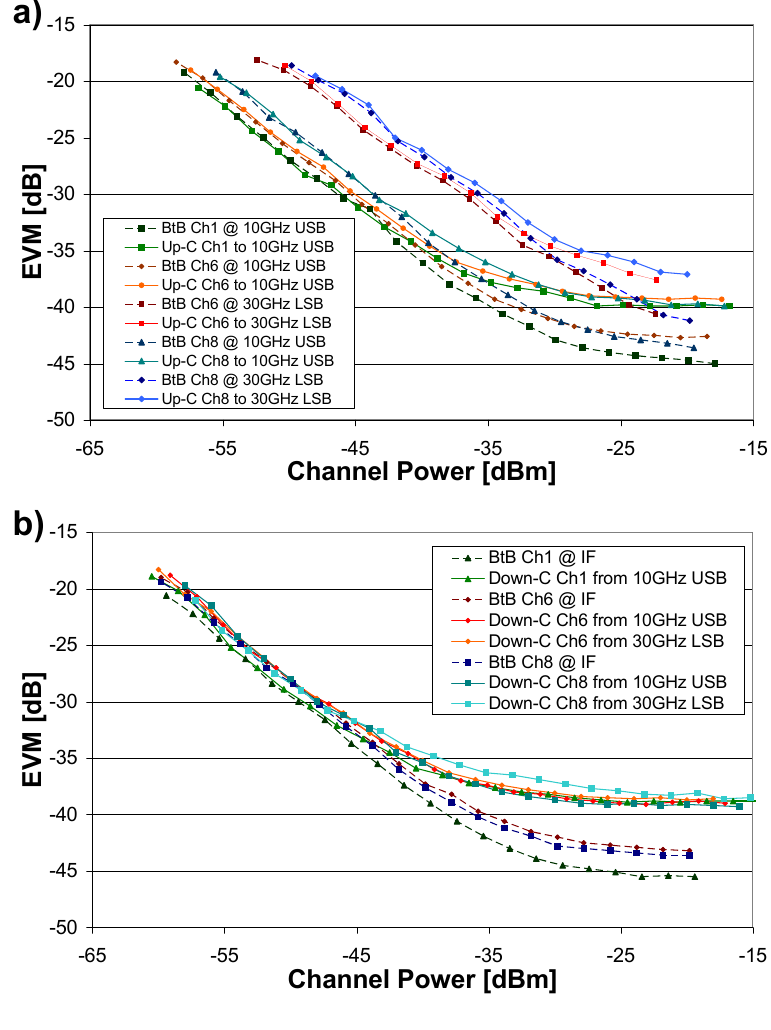
Figure 3. ( a ) Error vector magnitude (EVM) of channels 1, 6, and 8 up-converted to two different frequencies. Comparison between photonics-assisted up-conversion (Up-C) and electronic generation (BtB); ( b ) EVM of channels 1, 6, and 8 generated at IF (BtB), and of the same channels down-converted back to IF (Down-C) from higher carrier